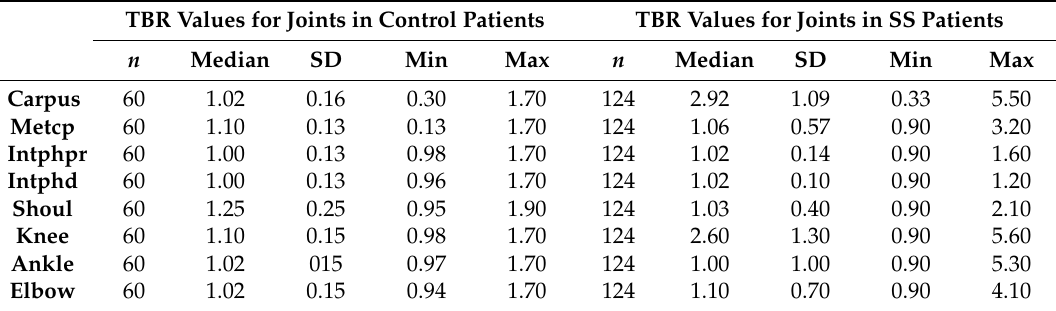
Table 2. TBR descriptions for joints in SS and control patients.